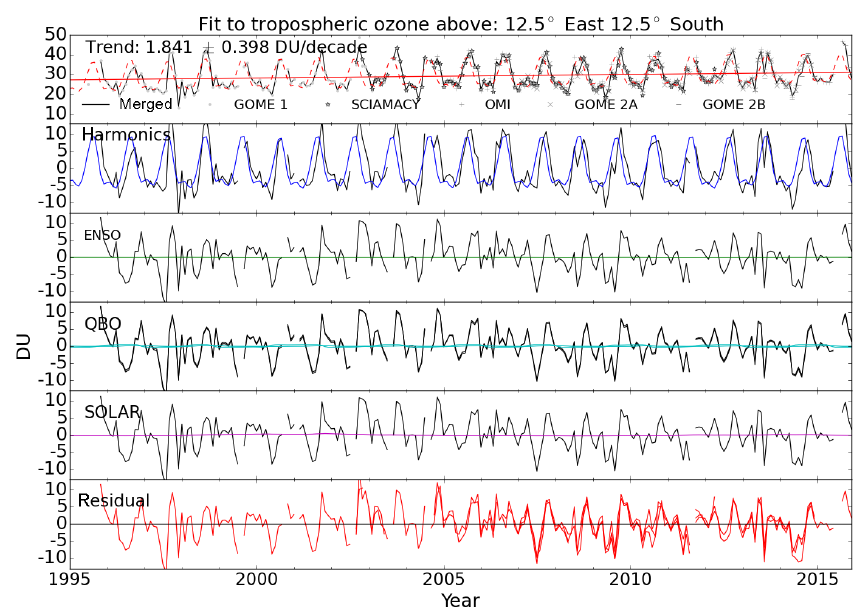
Figure 8. As Fig. 7 for the grid box showing the maximum trend. (10–15 ◦ E and 10–15 ◦ S African west coast). The time series is dominated by an annual cycle with a local ozone maximum in